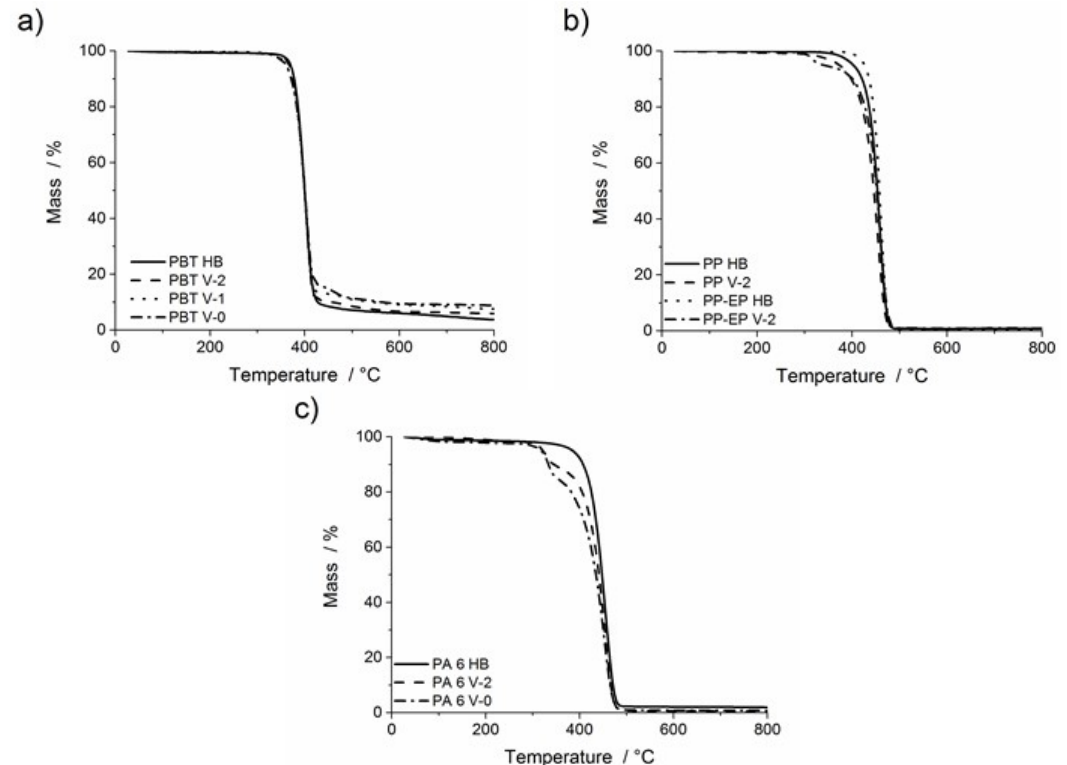
Figure 1. TGA under N 2 . Mass of: ( a ) poly(butylene terephthalate) (PBT) HB, PBT V-2, PBT V-1, PBT V-0; ( b ) polypropylene (PP) HB, PP V-2, PP-ethylene-propylene (EP) HB,